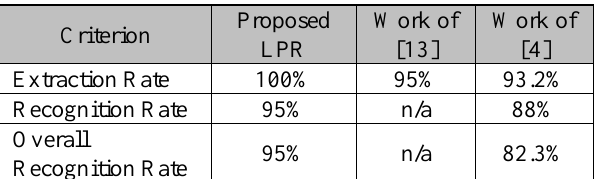
Table 1. Performance result with comparison against